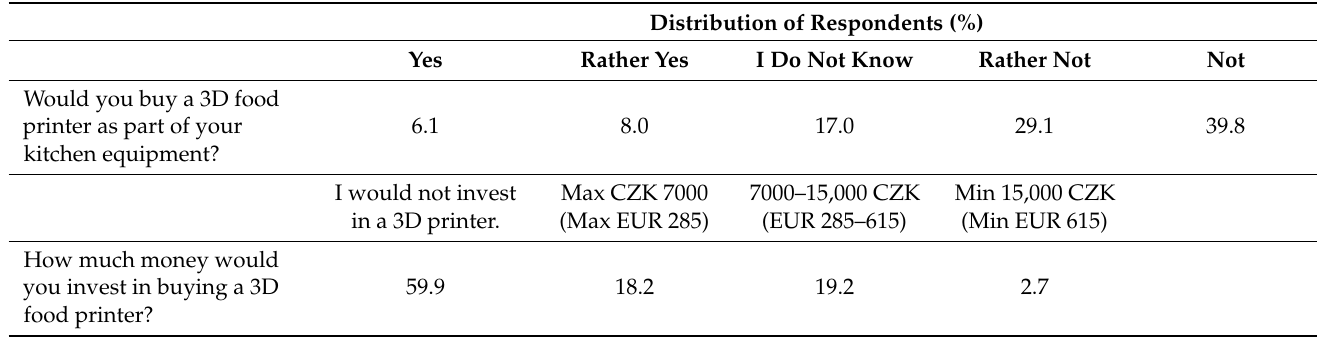
Table 5. Three-Dimensional Food Printing, Investments. Distribution of respondents (%). Distribution of Respondents